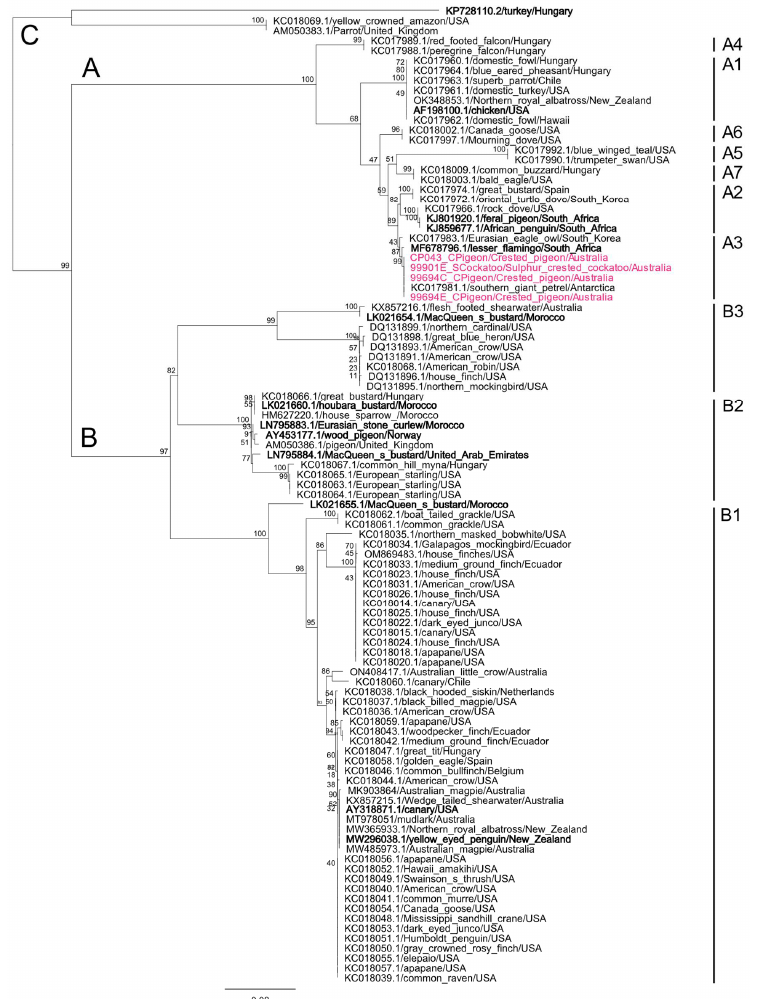
Figure 5. Maximum likelihood (ML) phylogenetic tree from partial nucleotide sequences of the P4b gene from four Avipoxvirus sequences detected from avian species in this study and global Avipoxvirus reference strains. ICTV-ratified species are indicated in bold black text. Major clades and subclades are designated according to Gyuranecz et al. [28], with branches labelled ( A – C ) indicating major Avipoxvirus clades and subclade names are provided adjacent to tip names. Branch tip labels show the GenBank accession number/common name/country of origin, with Avipoxvirus sequences detected from this study being boldened in pink. Bootstrap values are shown as a percentage. The scale bar indicates the number of nucleotide substitutions per site.